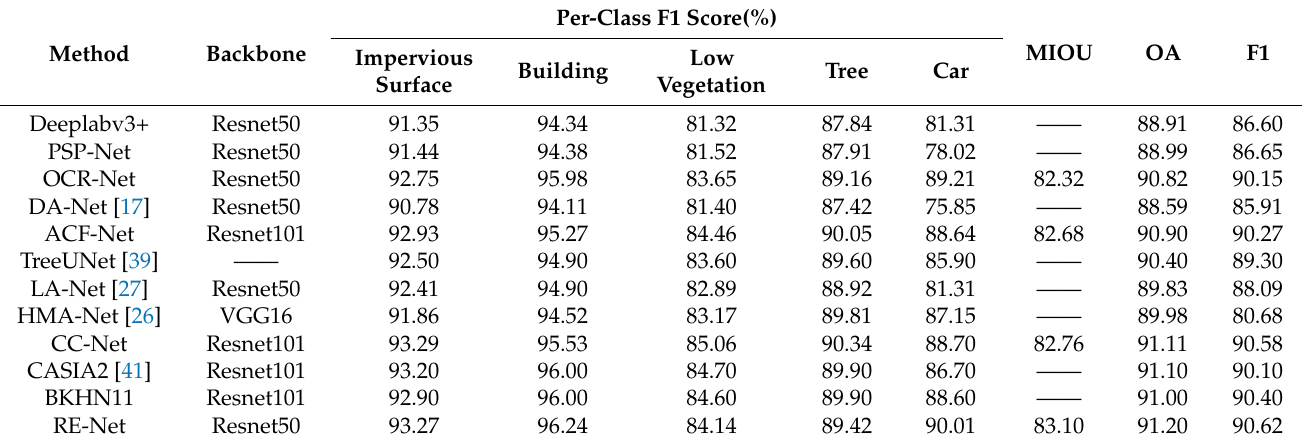
Table 3. The results of each model on Vaihingen. MIOU, the mean intersection over Union; OA, the overall accuracy.